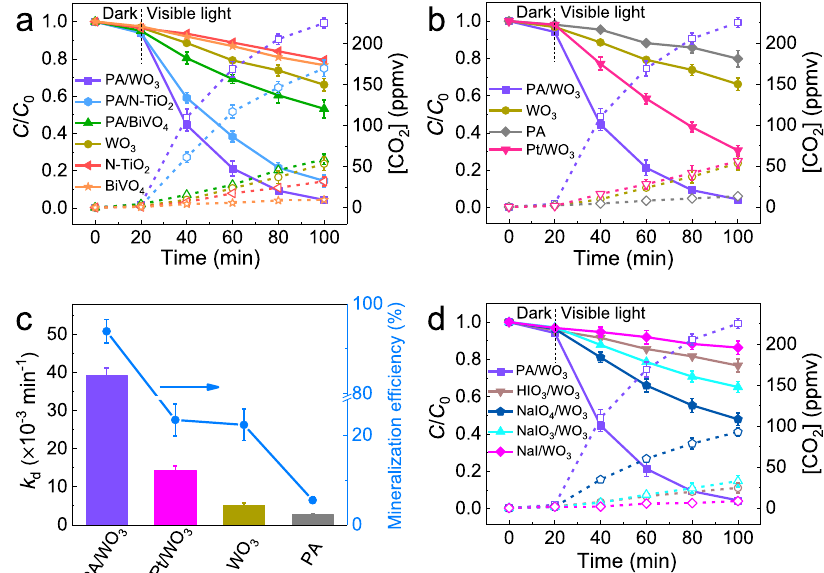
Fig. 1 Visible light-driven PCD of acetaldehyde (AA). a The time pro fi les of the PCD of AA and the accompanying production of CO 2 on bare and PA- treated WO 3 , N-TiO 2 , and BiVO 4 . b The PCD comparison between PA/WO 3 and Pt/WO 3 . c The PCD rate constant ( k d ) and the mineralization ef fi ciency after 80 min reaction for PA/WO 3 , Pt/WO 3 , bare PA, and WO 3 . d PCD activities of WO 3 treated with different iodine reagents. The dashed lines with open symbols represent the CO 2 concentration generated from AA degradation. Error bars are de fi ned as standard deviation. Experimental conditions: [AA] 0 = 120 ppmv; visible light ( λ > 420 nm) intensity of 2.2 mW/cm 2 ; sample amount of 50 mg; RH 65%; reaction temperature of 30